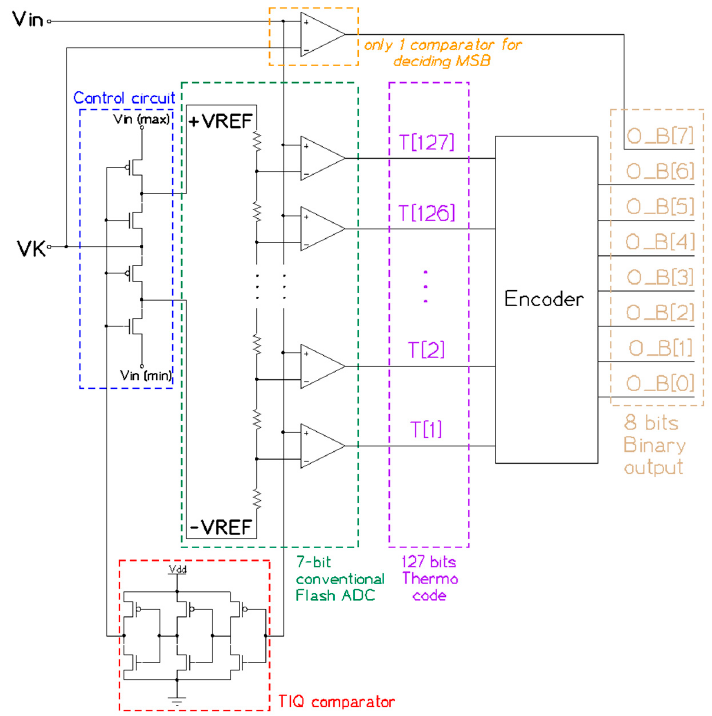
Figure 4. The detailed structure of the Comparator block.